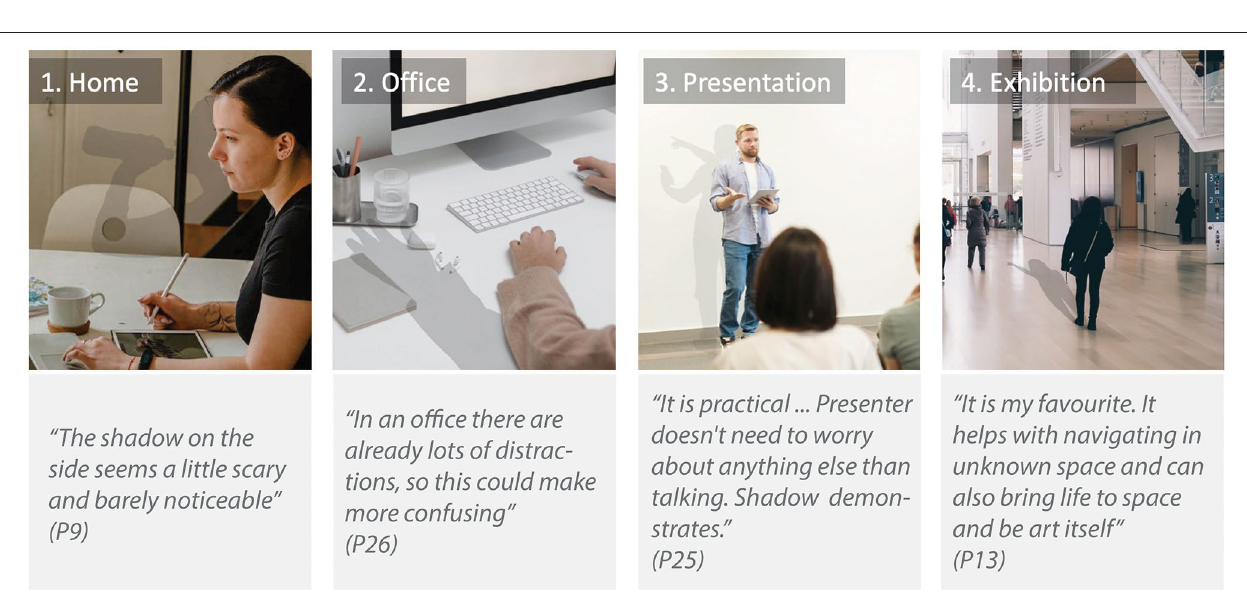
FIGURE 7 | Scenarios and examples of user feedback for shadows as information displays. In each image observe the augmented shadow. (Image source: 1. Photo by ANTONI SHKRABA from Pexels; 2. Photo by Cup of Couple from Pexels; 3. Photo by fauxels from Pexels; 4. Photo by Ricardo Esquivel from